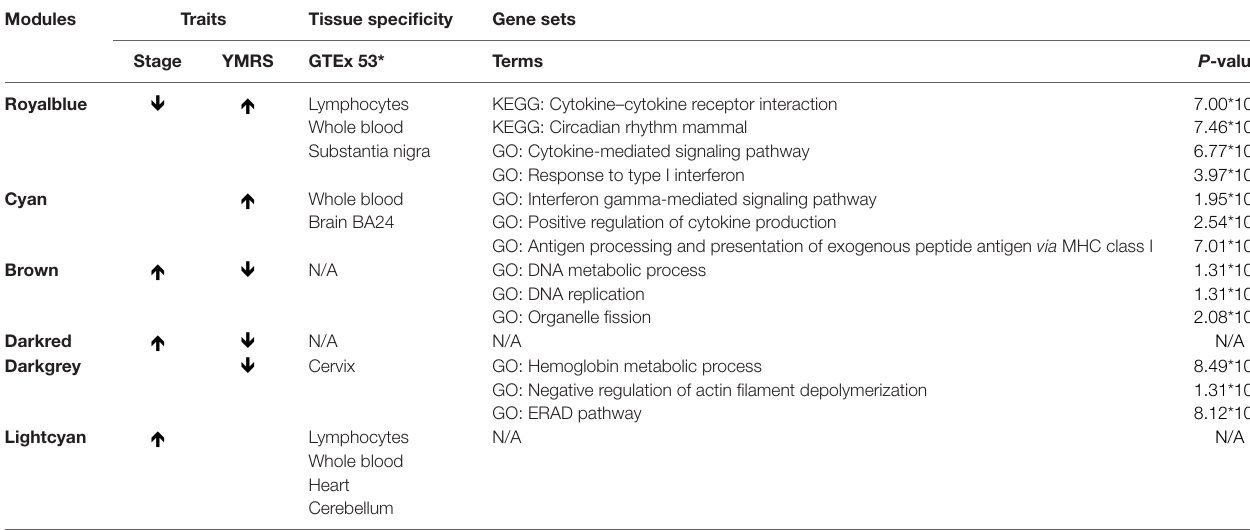
TABLE 3 | Mania-related modules and their enriched possible biological function. Modules